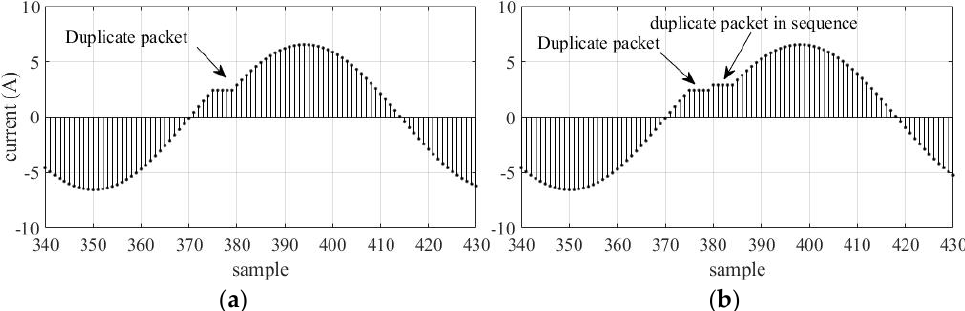
Figure 3. Current signal with packet duplicate. ( a ) Duplicate packet. ( b ) Duplicate packet in sequence.